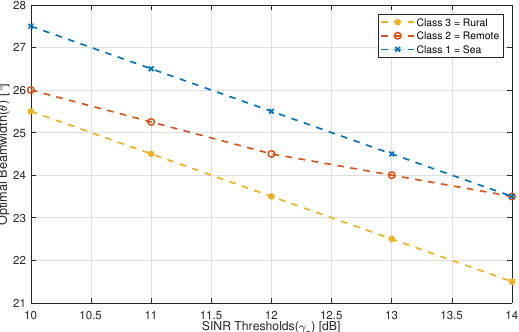
Figure 9. An example of the availability percentage varies with the antenna beamwidth and the SINR threshold in Class 1. The dots indicate the simulation data and the heat map is the surface fitting using (18).